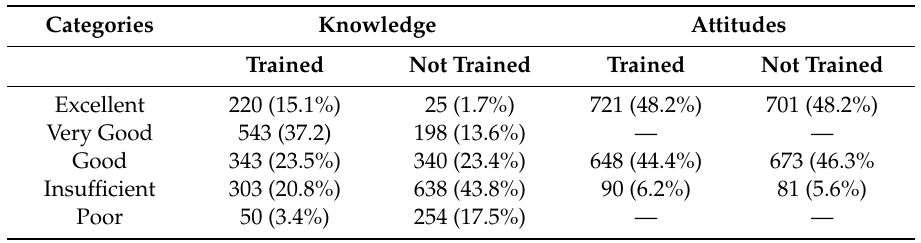
Table 3. Category scales for level of knowledge and attitudes toward use of contraceptive